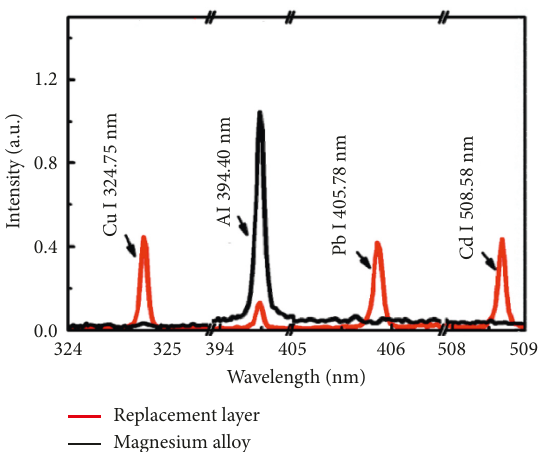
Figure 14: LIBS spectra of magnesium alloy (solid black line) and replacement layer (solid red line) from mixed solutions of different salts (CrCl 3 , CdCl 2 , CuCl 2 , and Pb(NO 3 ) 2 ; adapted from